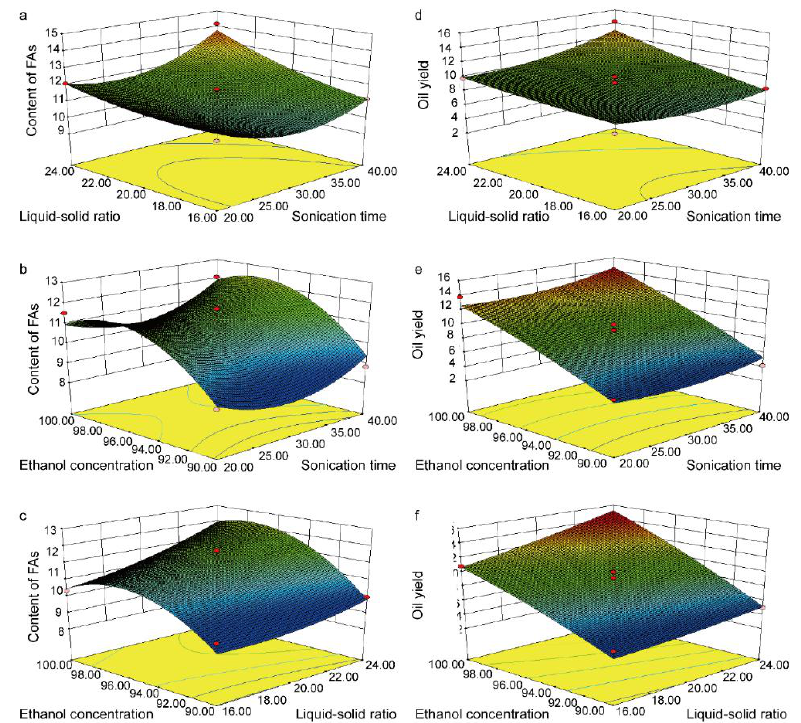
Figure 3. Response surface plot for interactions between three independent variables on contents FAs (mg/g, a , b , and c ) and oil yield (%, d , e , and f ). Two variables were plotted against each other in each panel.